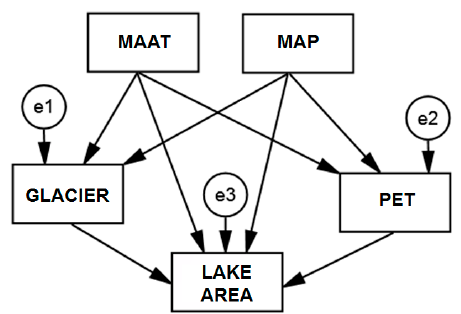
Figure 2. The structural equation model (SEM) hypothesized structural model.